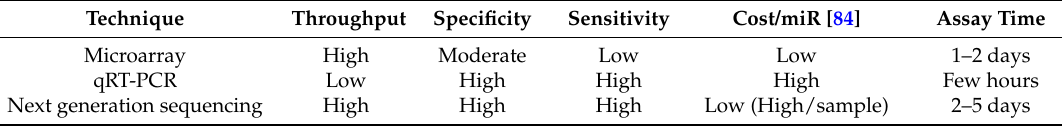
Table 2. Comparison of nucleic acid-based cancer screening